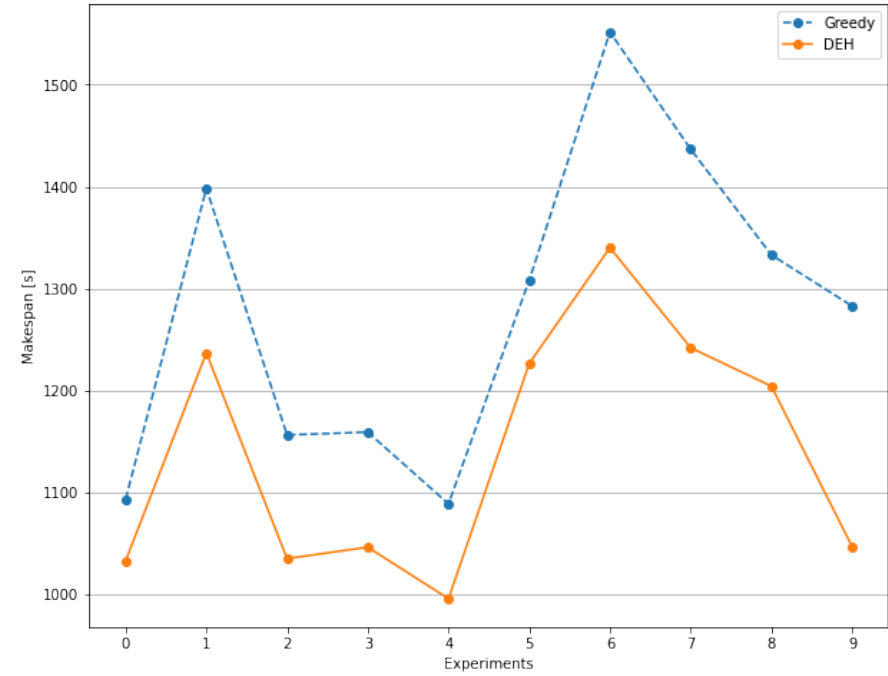
Figure 6. Results of the DEH on the SLC-AS/RS.